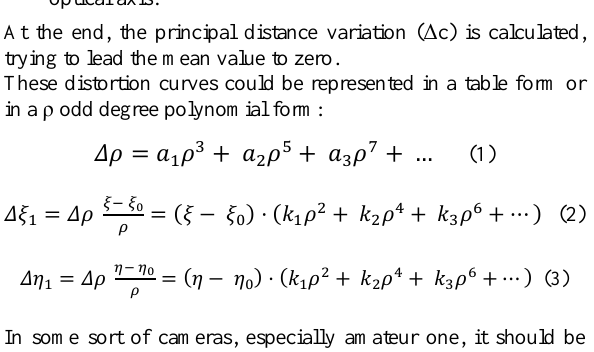
parameters and the distortion values.